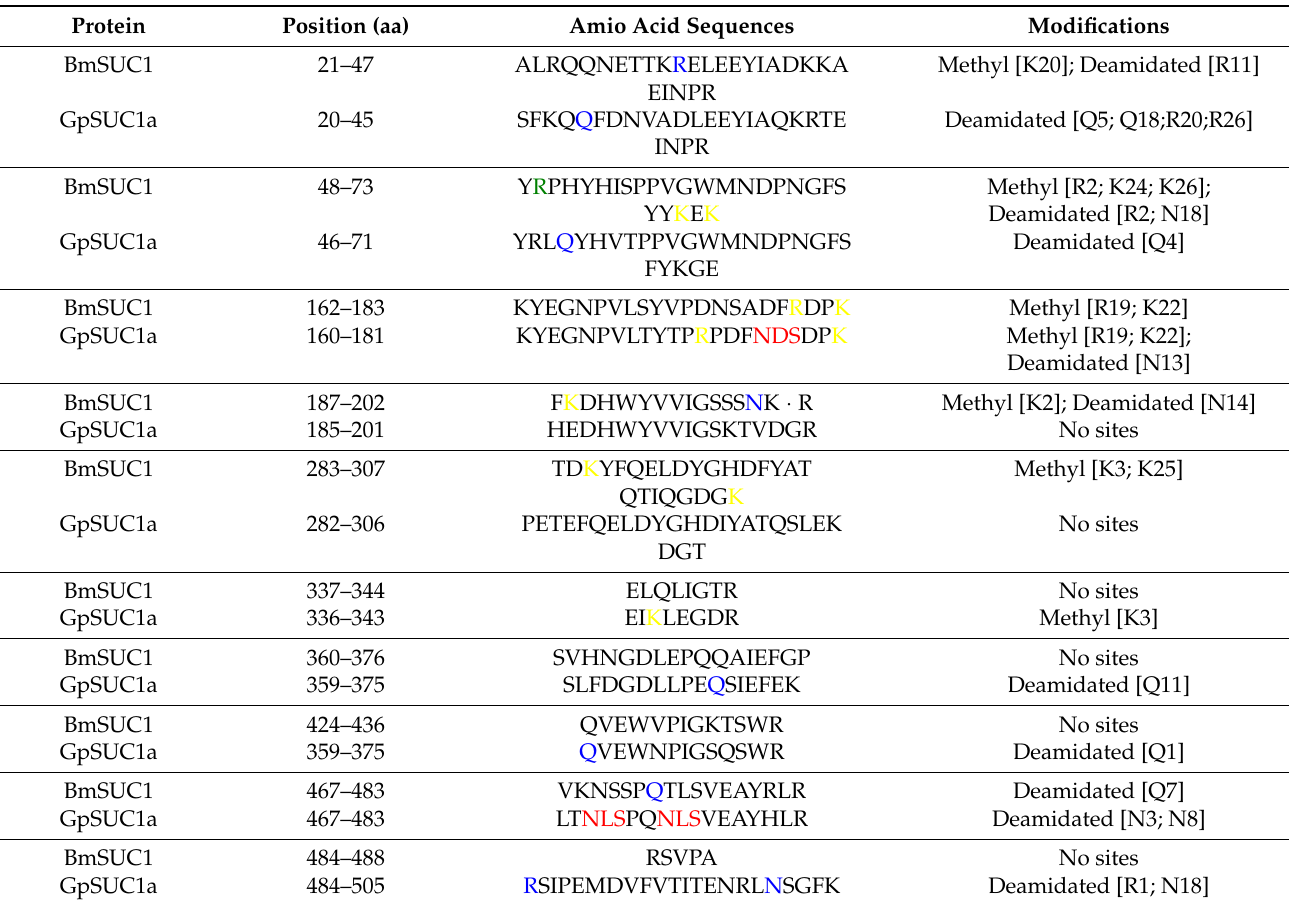
Table 3. Comparative identification results of BmSUC1 and GpSUC1a about N-glycosylation and